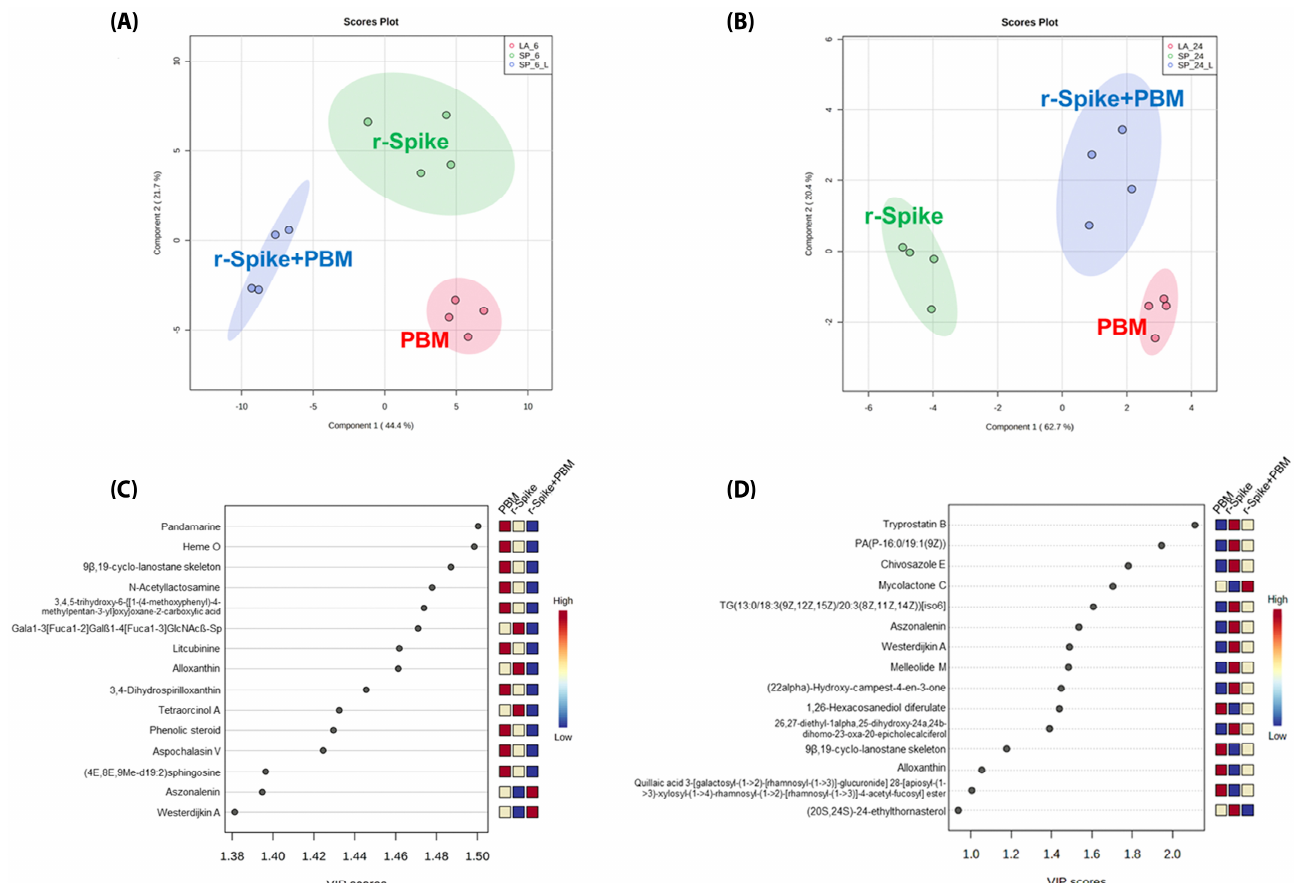
Figure 4. Supervised data analysis from metabolomics data to differentiate the PBM, rSpike, and (rSpike + laser) groups. ( A ) PLS-DA of the 6 h groups; ( B ) PLS-DA of the 24 h groups; ( C ) Variable importance for the projection (VIP) graph for the 6 h groups’ comparison; ( D ) VIP graph for the 24 h groups’ comparison.